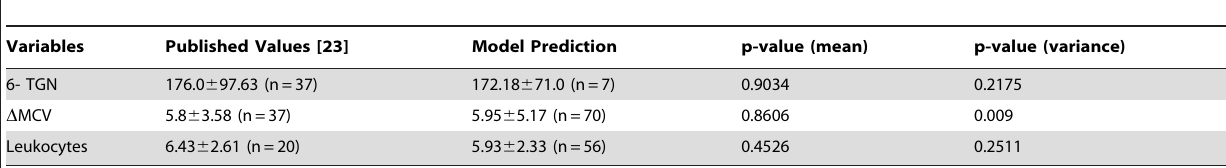
Table 6. Comparison between model-predicted values (mean 6 SD) and published clinical results for model response variables.